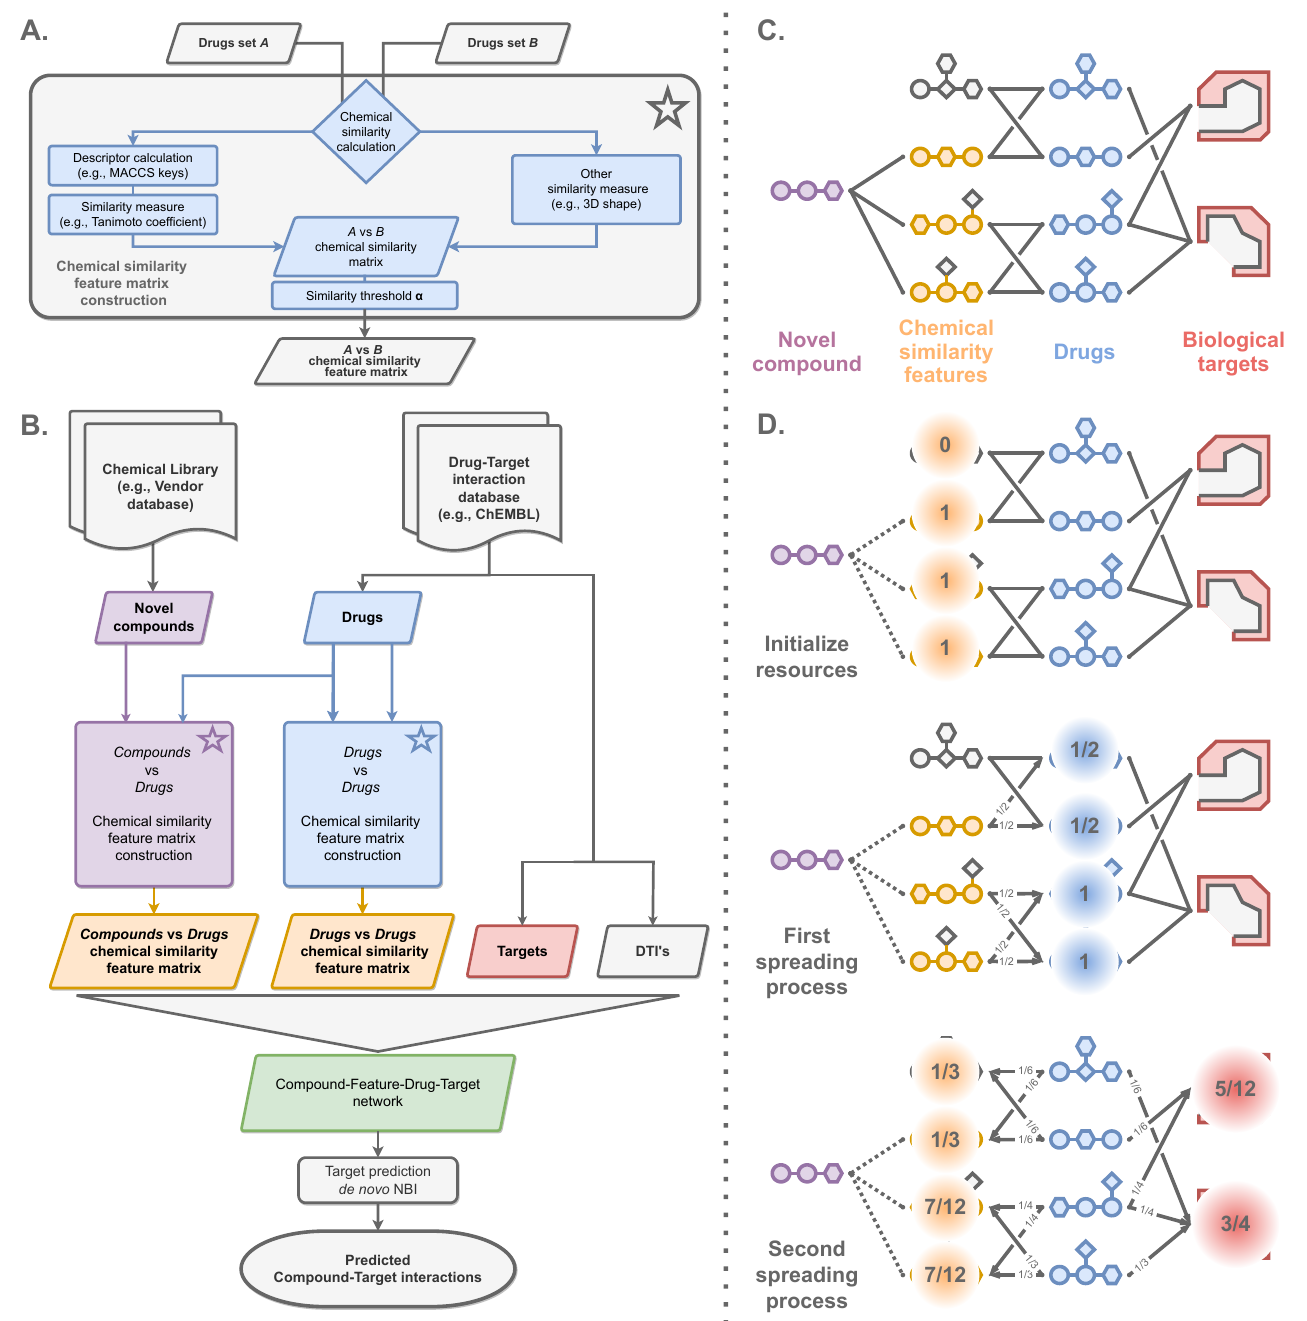
Figure 1. Schematic representation of SimSpread. ( A ) Chemical similarity feature matrix con- struction from two different sets of drugs. ( B ) De novo target prediction pipeline of SimSpread. ( C ) Tetra-layered network employed by SimSpread for de novo target prediction. ( D ) Schematic representation of the de novo NBI resource-spreading algorithm on the tri-layered drug–drug–target subnet. Here, fractions placed on the nodes represent the amount of resources stored in a given resource-spreading process, arrows indicate resource spreading direction and fractions in arrows represent the amount of resources distributed. Please refer to the Section 3 for more